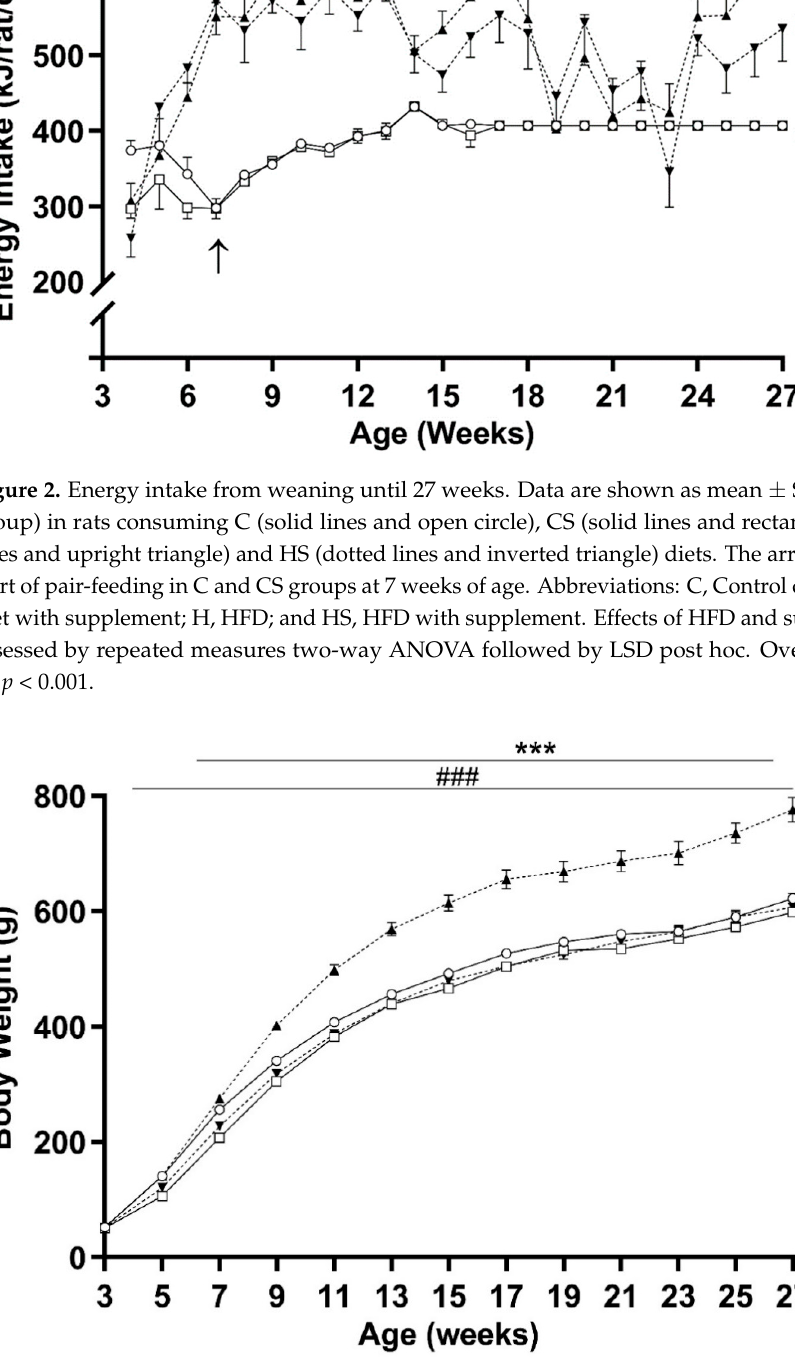
Figure 3. Body weight from weaning till 27 weeks. Data are shown as mean ± SEM ( n = 17 per group) in rats consuming C (solid lines and open circle), CS (solid lines and rectangle), H (dotted lines and upright triangle) and HS (dotted lines and inverted triangle) diets. Abbreviations: C, Control diet; CS, Control diet with supplement; H, HFD; and HS, HFD with supplement. Effects of diet and supplement were assessed by repeated measures two-way ANOVA followed by LSD post hoc. There was an interaction effect ( p < 0.001) of HFD and supplement for the whole period of animal growth. Overall HFD effect *** p < 0.001. Overall supplement effect ### p <